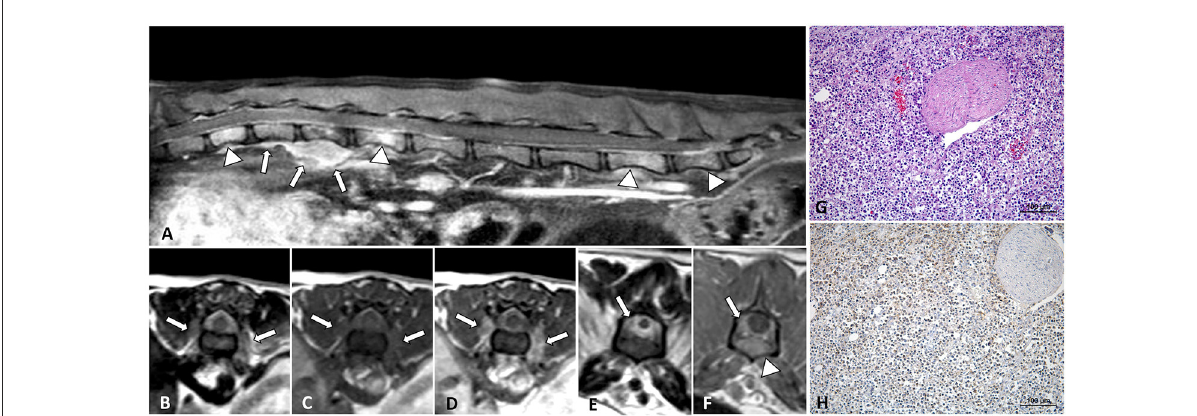
FIGURE4 MRI of an 8-year-old domestic short-haired paraplegic cat diagnosed with multicentric small-intermediate T-cell lymphoma. Sagittal plane T1W post-contrast SPIR of the caudal thoracic and lumbar vertebral column (A) shows a paravertebral mass ventral to the L1 vertebra and extending cranially to T12 and T13 vertebrae (arrows) and irregular hyperintensity on the bone marrow of several vertebral bodies (arrowheads). Transverse planes at the level of T13-L1 intervertebral space (B–D) show an extension of the paravertebral mass through the intervertebral foramina (arrows) and to the epidural space circumferential to the spinal cord. The lesion is hyperintense on T2W (B) , isointense on T1W (C) , and enhances with a mild heterogeneous pattern on post-contrast T1W (D) images. Transverse planes T2W (E) and post-contrast T1W (F) at the level of the L6 vertebra, show an epidural diffuse infiltrate (arrows) with similar signal features. Hyperintensity of the vertebral body with cortical sparing is also depicted (arrowhead in F ). On histopathology image, HE (G) neoplastic lymphoid cells are surrounding a nerve root, on IHC (H) T-lymphocytes, CD3-immune positive cells, predominate in the tumor.